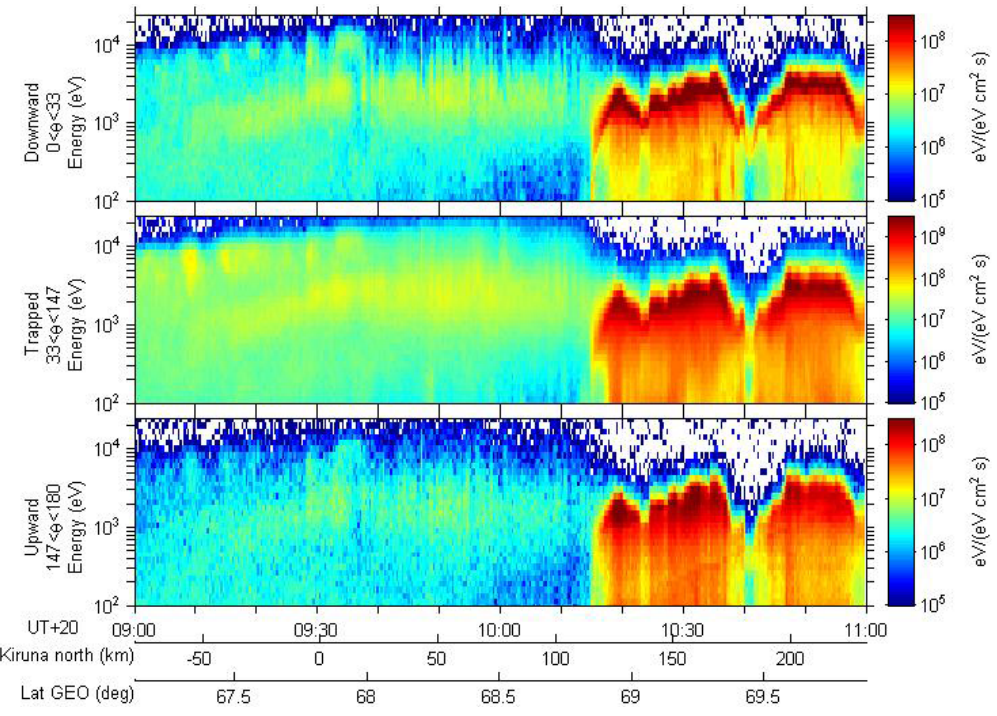
Fig. 5. The electron differential energy flux as a function of time and energy for the time interval 20:09:00–20:11:00UT. The upper panel presents the fluxes integrated over the pitch angle interval 0 <θ< 33 (downward), the middle panel the interval 33 <θ< 147 (trapped), and the bottom panel the interval 147 <θ< 180